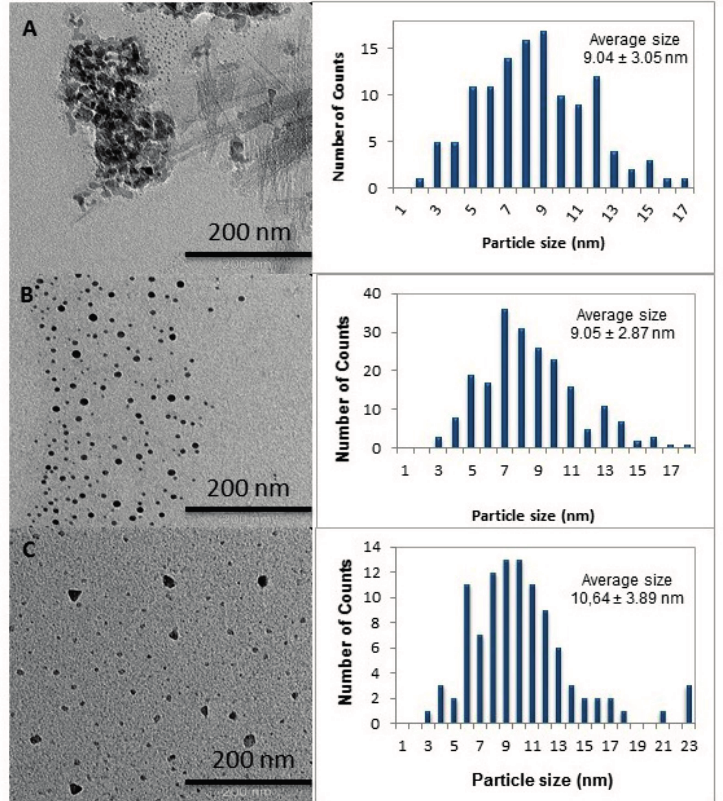
Figure 4. TEM micrograph and corresponding size distributions of chitosan ( A ), CHI-Q188 ( B ) and TMC ( C )-stabilized Fe(III) nanoparticles